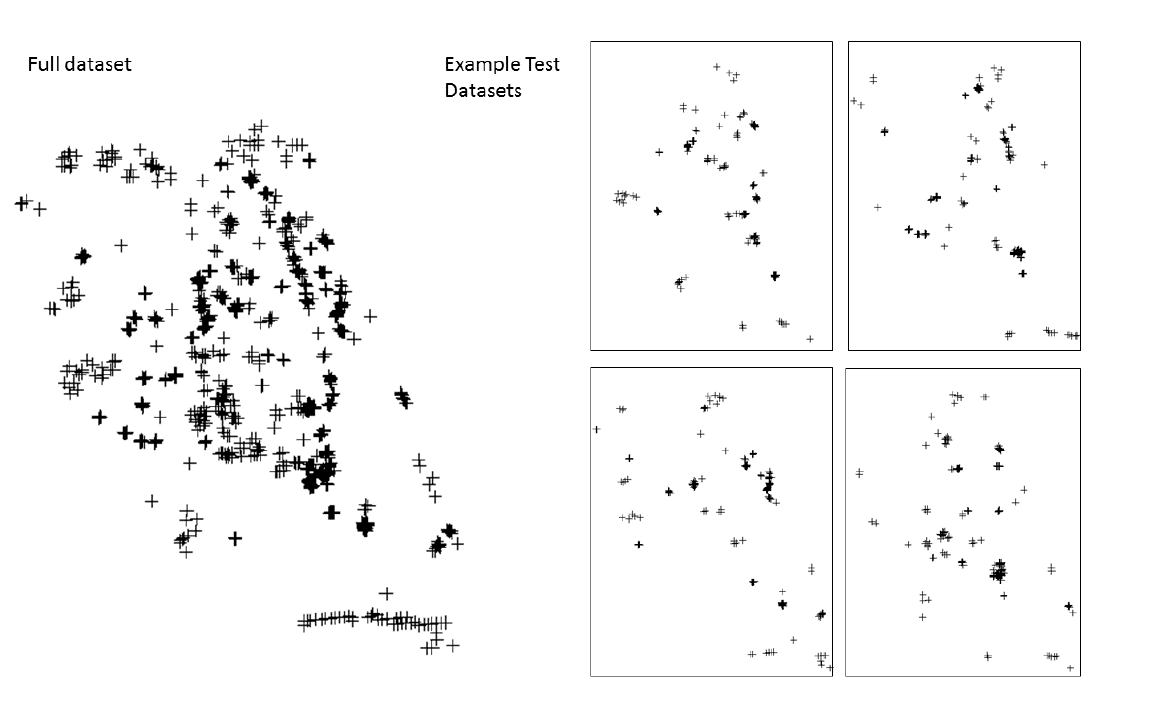
Figure A1.1. Sample training datasets generated by a spatial stratification algorithm used to